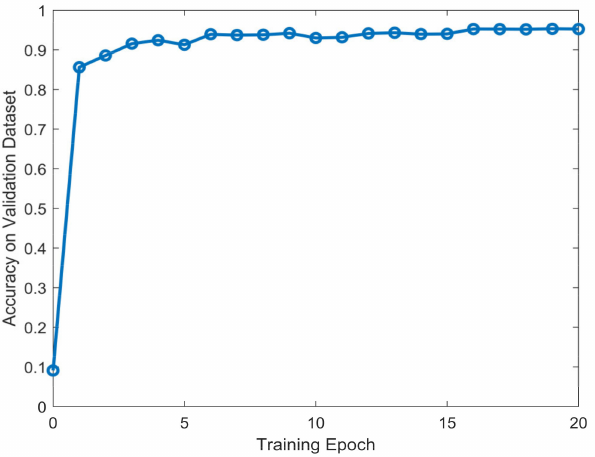
Figure 5. The value of average accuracy on validation dataset during the training session.